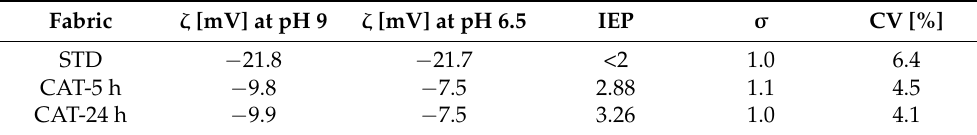
Figure 2. Electrokinetic potential of standard and cationized cotton fabrics vs. pH of 1 mmol/L KCl. Table 2. Electrokinetic potential at pH 9, pH 6.5 and Isoelectric point of standard and cationized cotton fabrics.